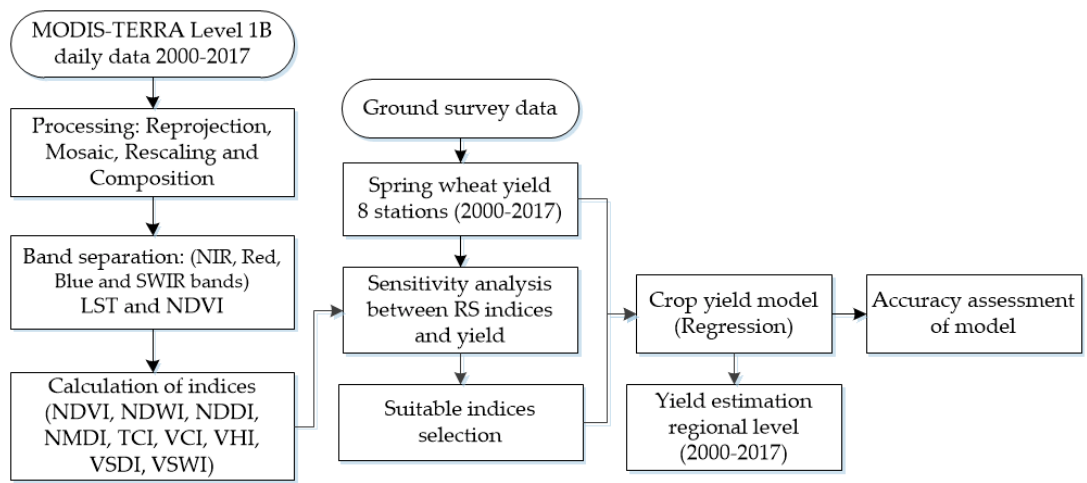
Figure 4. Flowchart of processing method